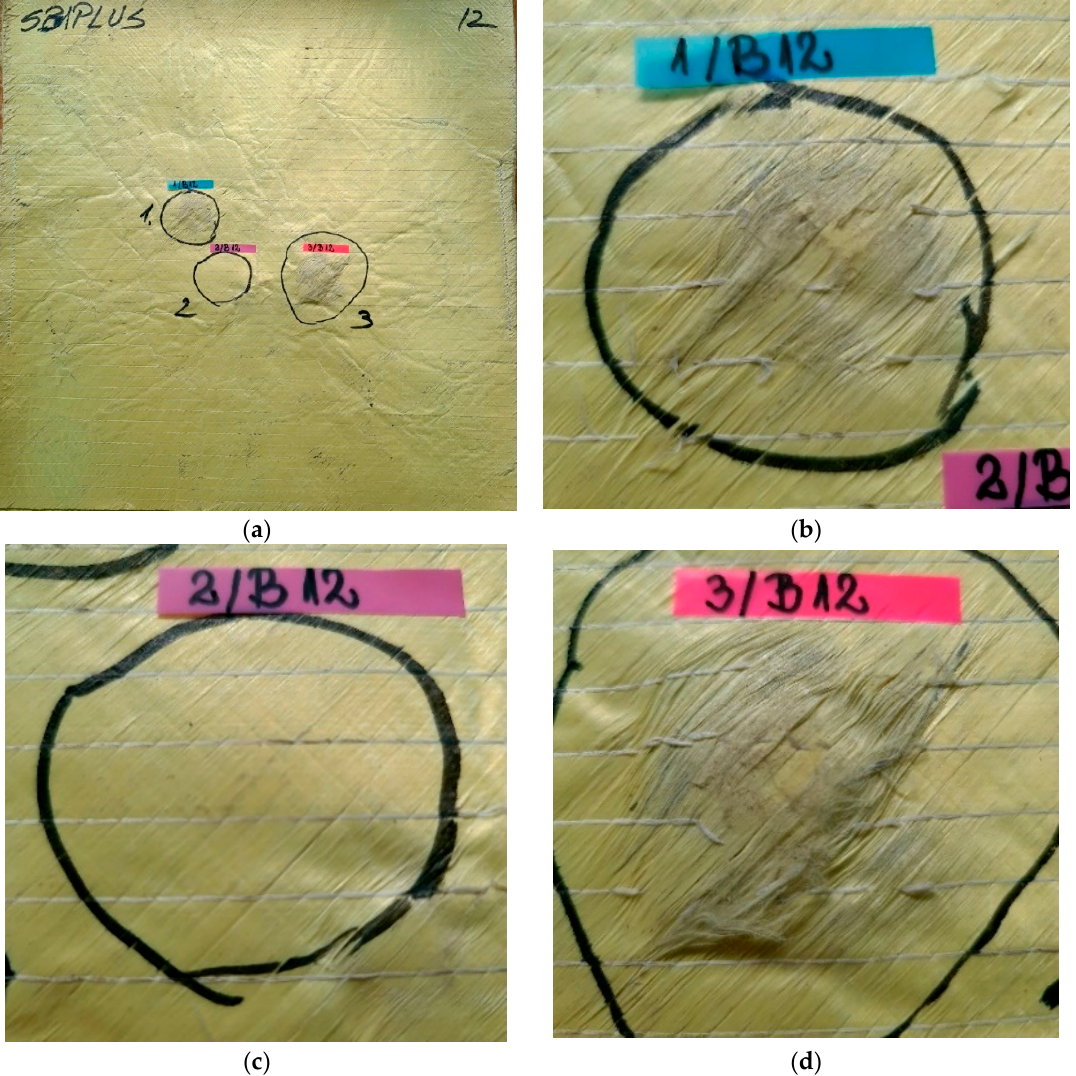
Figure 12. Back view of package made of 12 layers of LFT SB1plus: ( a ) layer 12 (back), with details of ( b ) fire 1, ( c ) fire 2 and ( d ) fire 3.